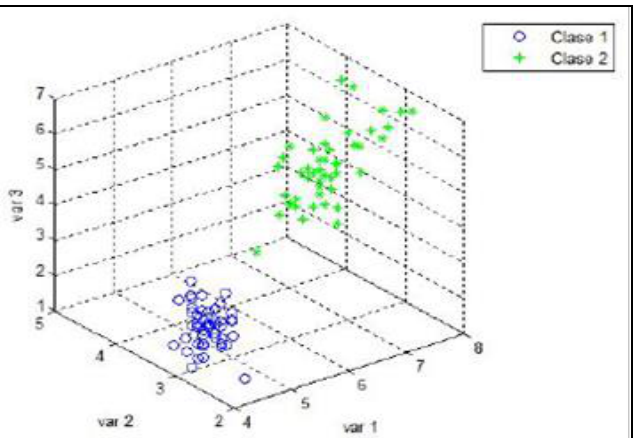
Figura 3: Clases totalmente separadas. Fuente: Los Autores, (2018).